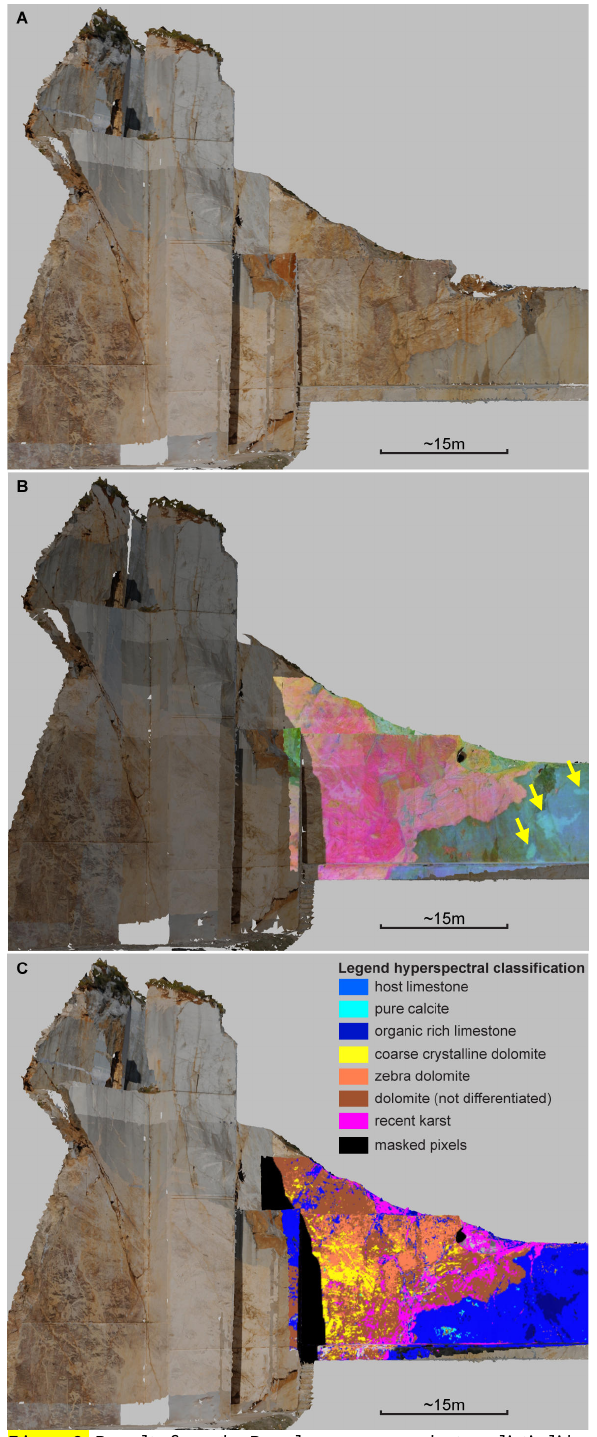
Figure 3. Results from the Pozalagua quarry: photorealistic lidar model (A) textured with B) MNF image; C) a hyperspectral classification (MTMF classification).